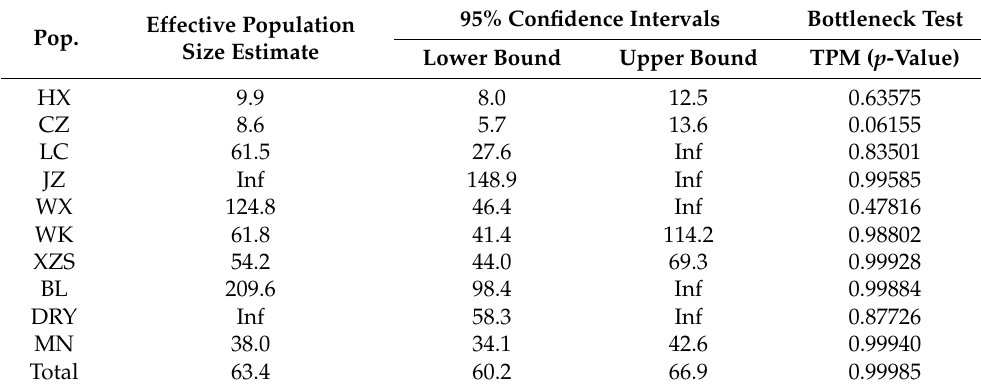
Table 4. Effective population size estimates with 95% confidence intervals and results from the bottleneck analysis for the 10 C. carpio populations using 20 microsatellite